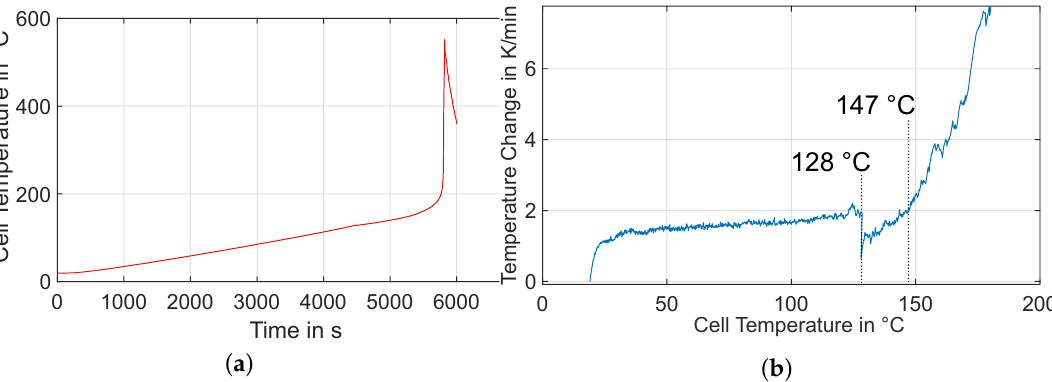
Figure 8. Experiment HT1: Left ( a ): Behavior of the cell temperature over time. Right ( b ): Rate of temperature change as a function of cell